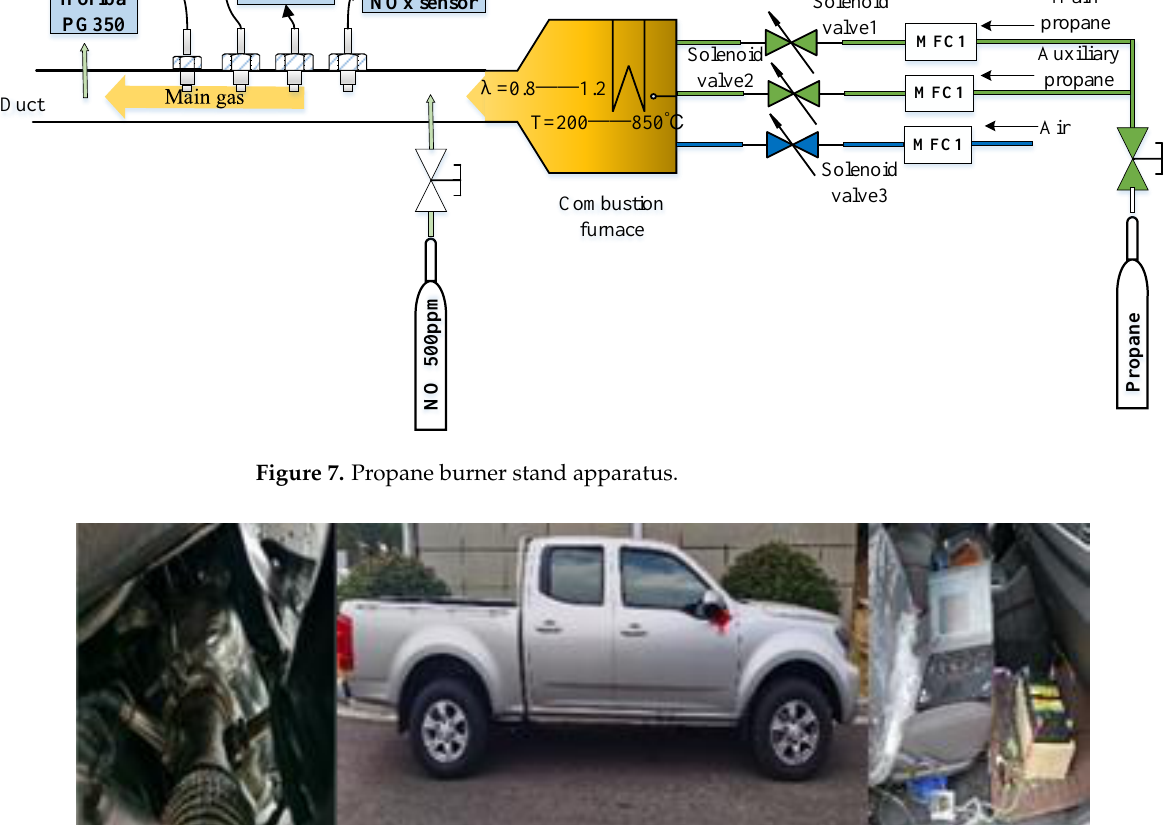
Figure 9. Revolving drum test bench. 4.3. Test Results The NOx sensor was in normal operation, and the oxygen was set to 21% in vol. The V 0 output was recorded with the change in the Ip 1 set point in the pump closed control loop, as shown in Figure 10. Figure 10. The relationship between the V 0 and Ip 1 .